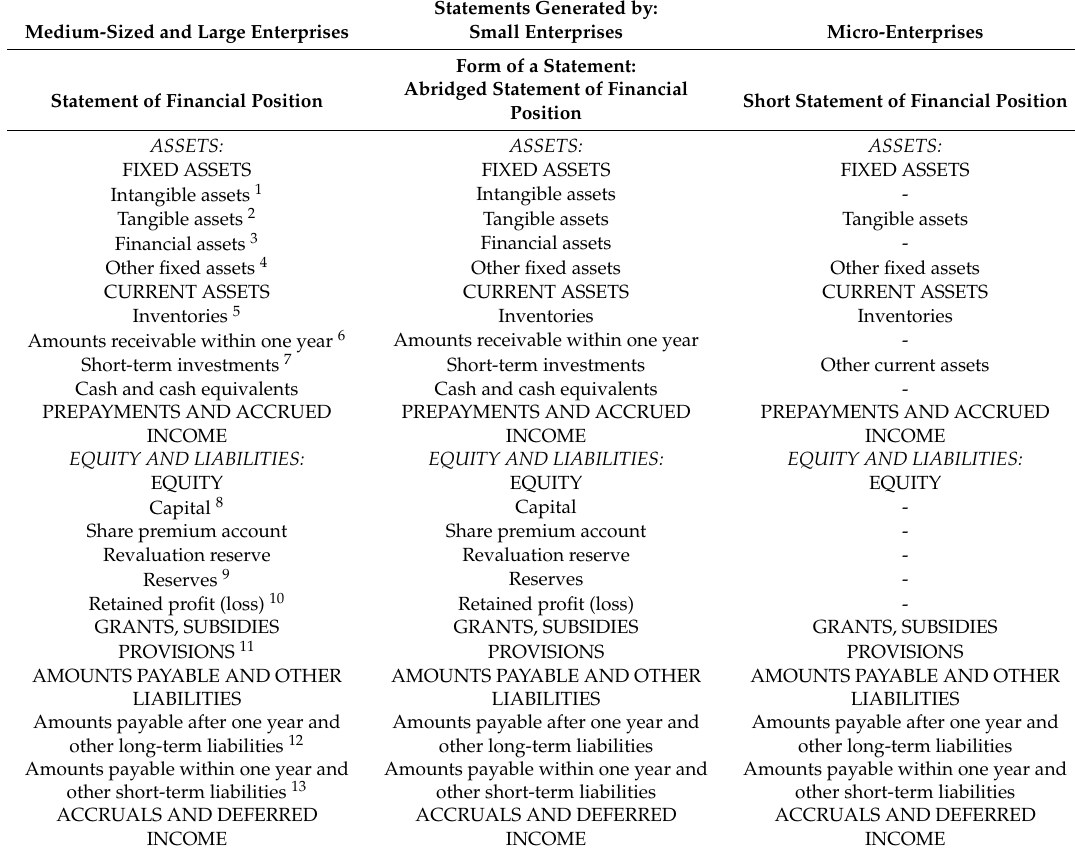
Table A1. Comparison of financial statements of enterprises of di ff erent sizes—statement of financial